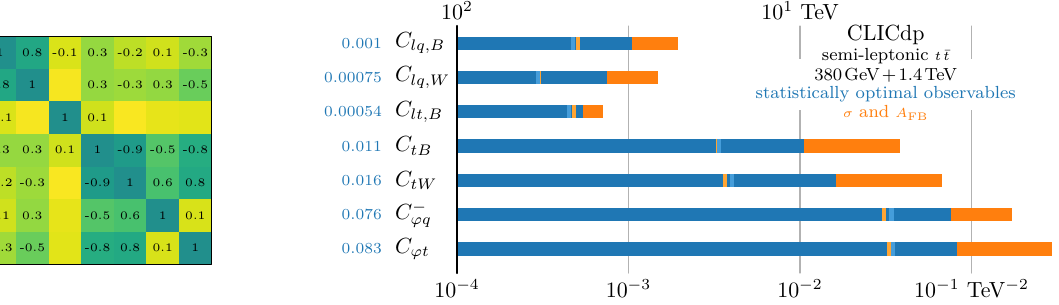
Figure 33. Global EFT analysis results for top-quark pair production at the 380 GeV and 1 : 4 TeV CLIC, using respectively 1 : 0 ab (cid:0) 1 and 2 : 5 ab (cid:0) 1 , equally shared between (cid:6) 80% electron beam polar- isation con(cid:12)gurations at the initial stage and split in the ratio 80:20 at the higher-energy stage. 1 (cid:27) sensitivities to the seven Wilson coe(cid:14)cients for the combination of A bars, and for the statistically optimal observables in blue bars. The corresponding single-operator sensitivities are shown as ticks of the same colour for the two set of operators. The correlation matrix among the Wilson coe(cid:14)cients for the (cid:12)ts using the statistically optimal observables (left). Empty matrix elements indicate values closer to 0 than to 0.1.